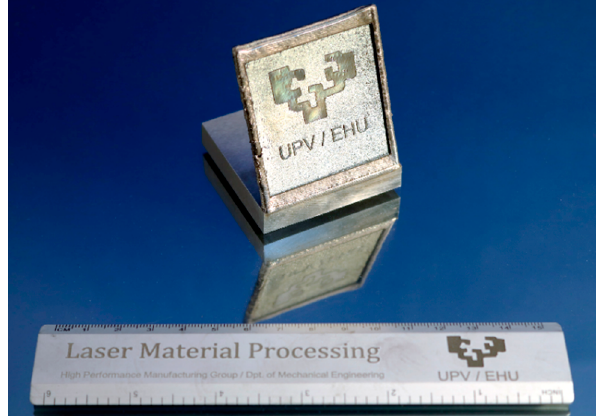
Figure 13. Final shape of the manufactured final test part.